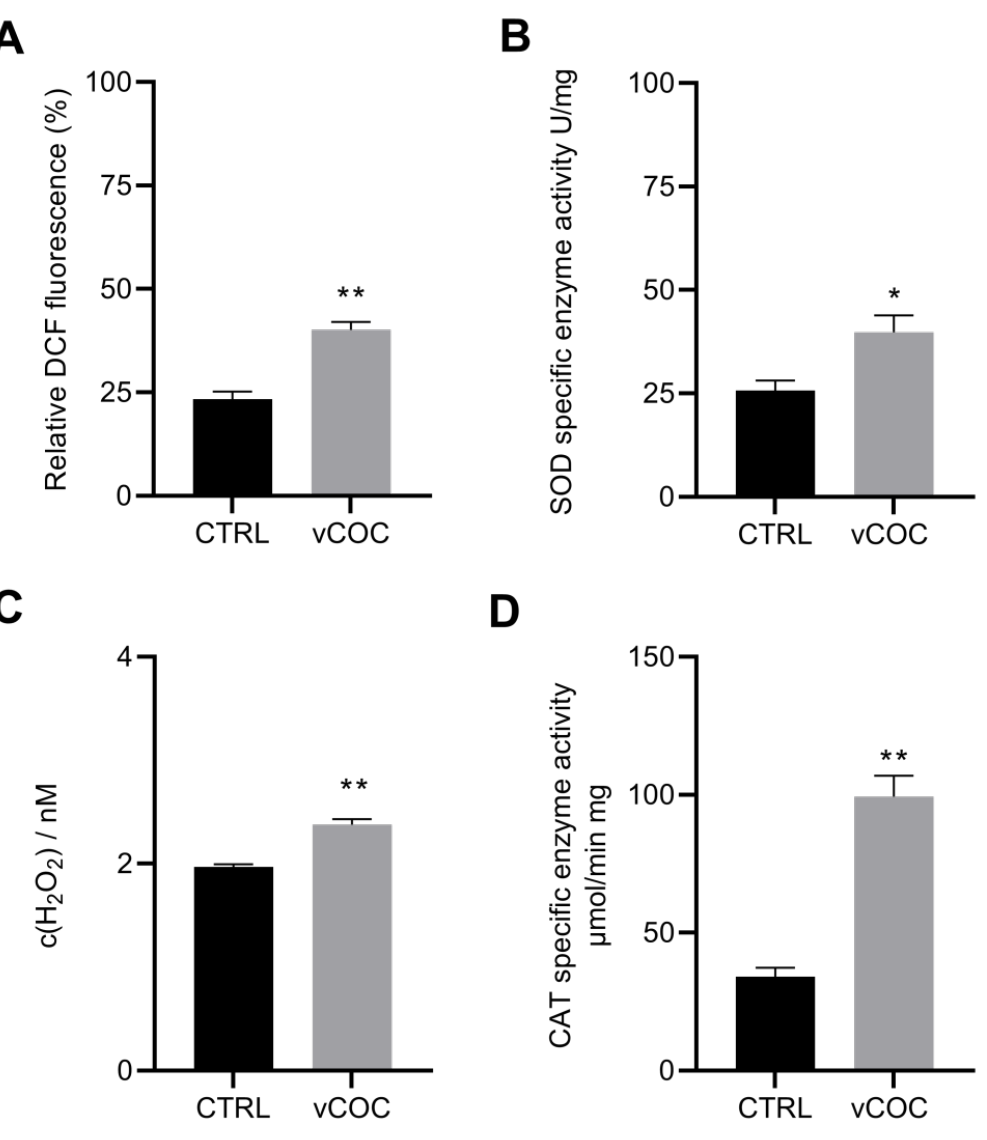
Figure 3. Two exposures to vCOC lead to stronger perturbation of redox balance relative to a single exposure. Male flies were exposed to 75 µ g of volatilized cocaine (vCOC) at 07:00 and 13:00 or hot air, control (CTRL). The following parameters were measured in whole body homogenates six hours after the second exposure: ( A ) reactive oxygen species (ROS) production, ( B ) superoxide dismutase (SOD) specific enzyme activity, ( C ) hydrogen peroxide (H 2 O 2 ) concentration and ( D ) catalase (CAT) specific enzyme activity. All measurements were performed in triplicate ( n = 9). *: p < 0.05, **: p < 0.01 using unpaired Student’s t